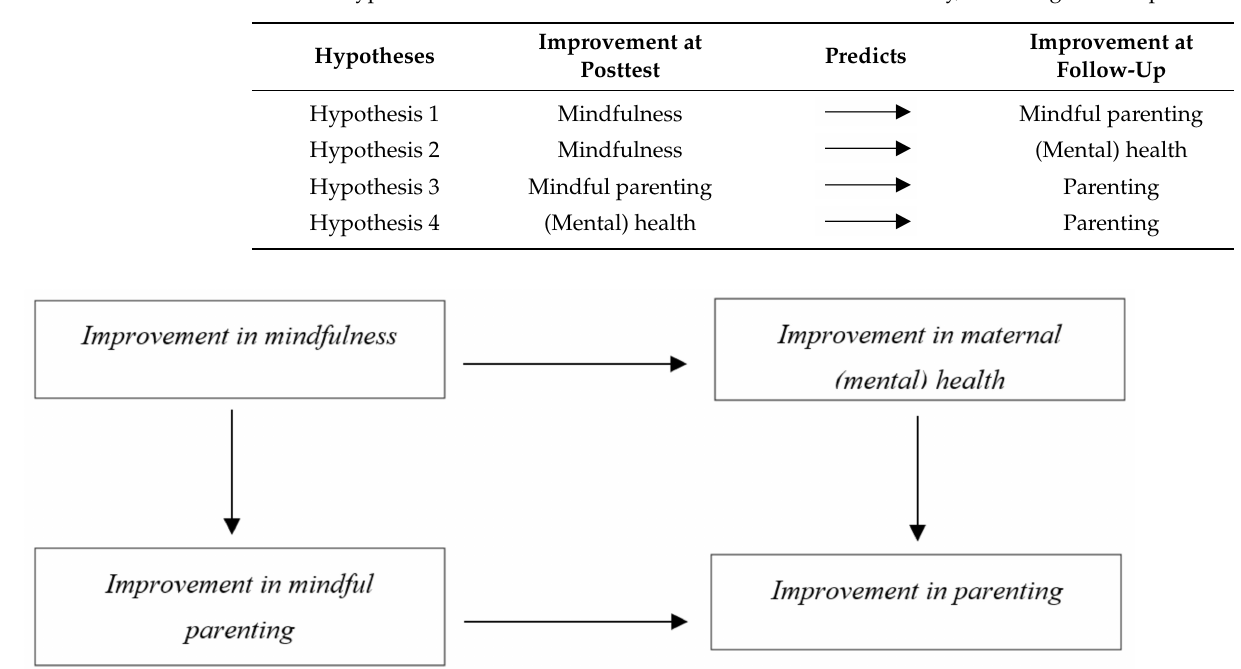
Table 1. Hypotheses on mediation of effects of Mindful with Your Baby, including the timepoints.